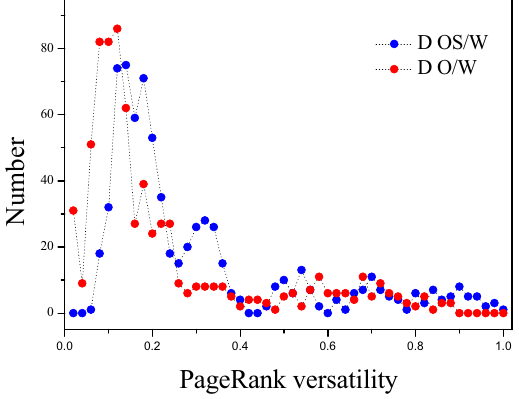
Figure 3. The PageRank versatility distribution in the derived MMBN.